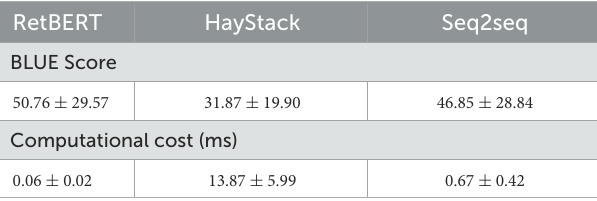
FIGURE4 The user interfaces that a farmer uses to diagnose cassava crop disease and ask agronomic questions.